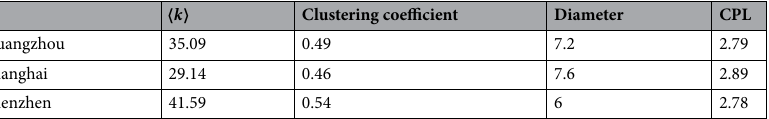
Table 1. Summary statistics of the generated MCNs with 1000 nodes. The MCNS correspond to the travel pattern during 8–8:30 AM on weekdays, and the statistics are measured using unweighted MCNs. Results are averaged from 10 random